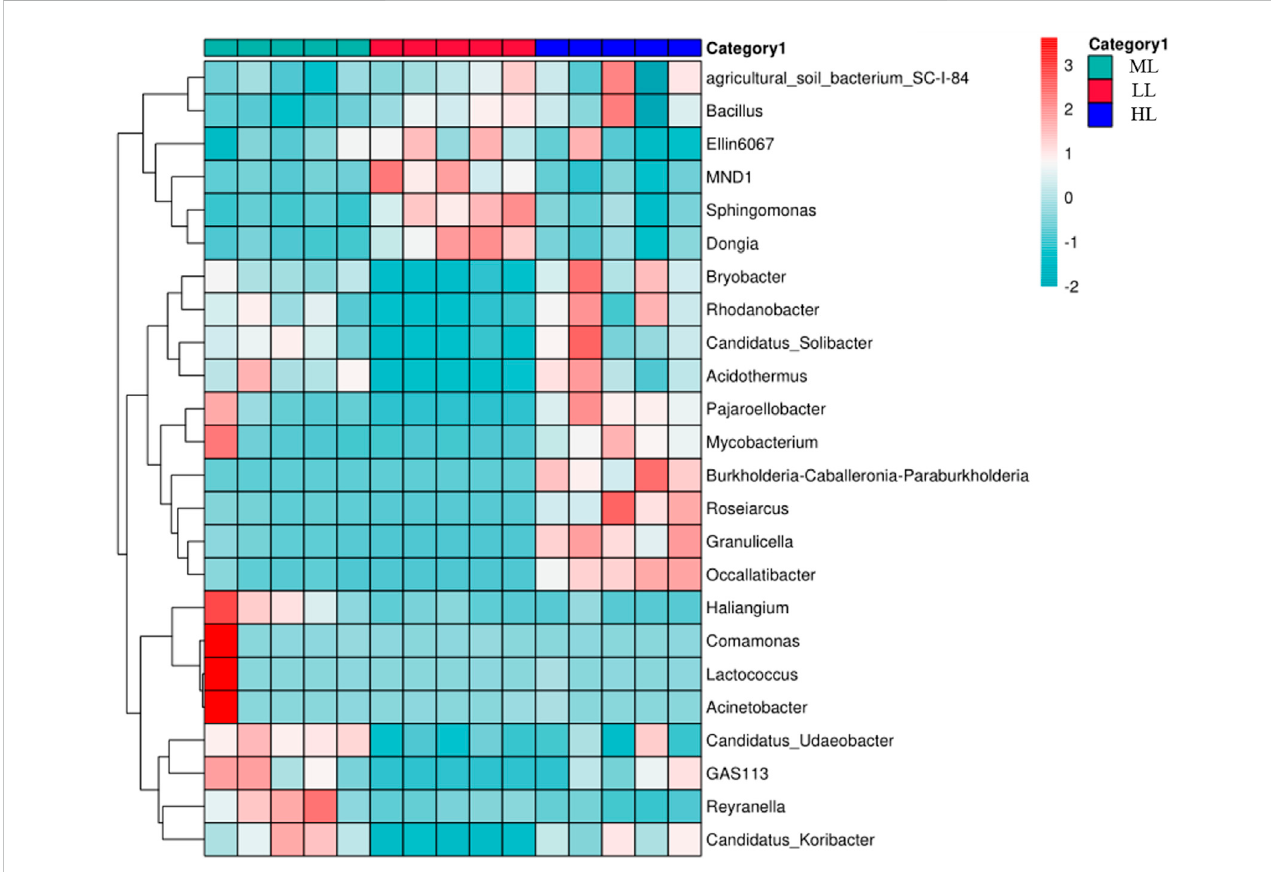
Heatmap and hierarchical clustering of the relative abundances of the top 24 genera detected in the individual soil samples. Co-enriched genera are ioutlined in red. LL, low-latitude; ML, mid-latitude; HL,